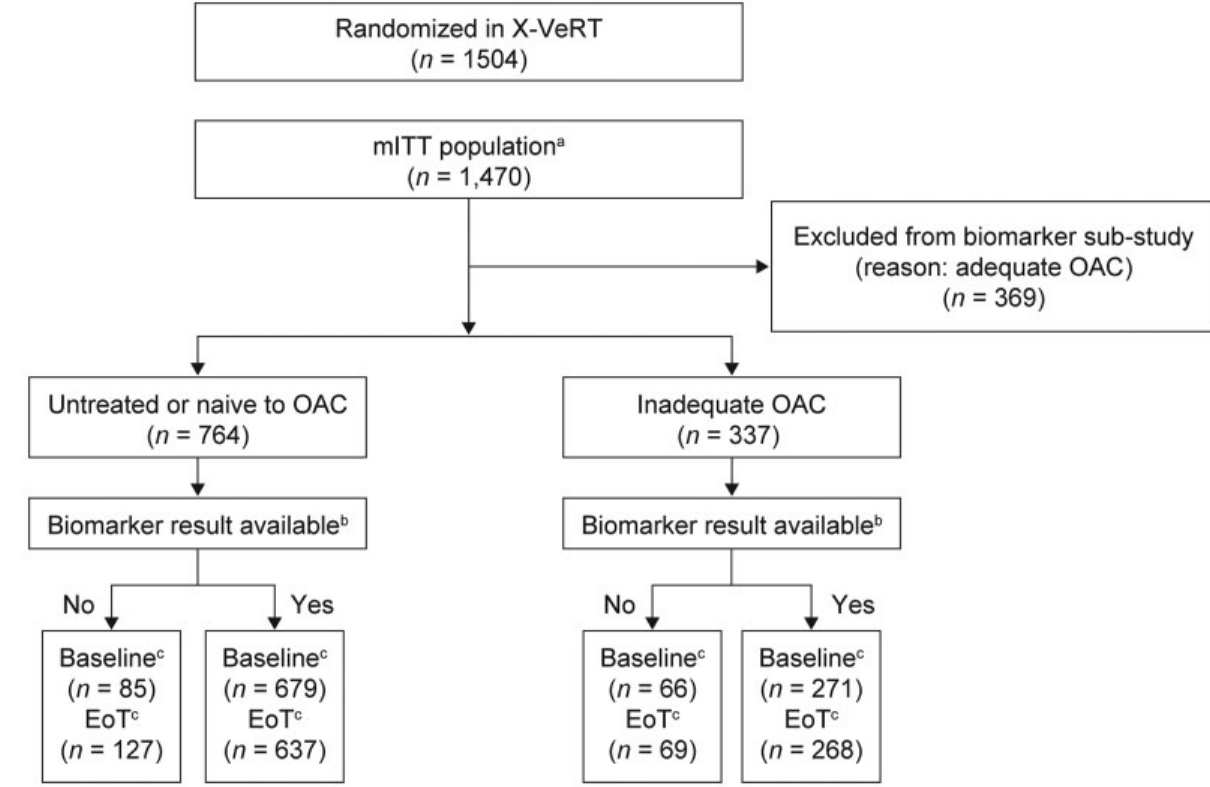
Fig. 1 Patient fl ow and overview of biomarker collection. EoT, end of treatment; hs-CRP, high-sensitivity C-reactive protein; mITT, modi fi ed intention-to-treat; OAC, oral anticoagulant. a Patients in the mITT population in whom a left atrial thrombus was not diagnosed during transesophageal echocardiography performed before the fi rst planned cardioversion. b Reasons for missing results, for example, specimen not frozen, insuf fi cient quantity, hemolysis. c Availability of samples based on available hs-CRP measurements; end of treatment samples could still be collected from patients without a baseline